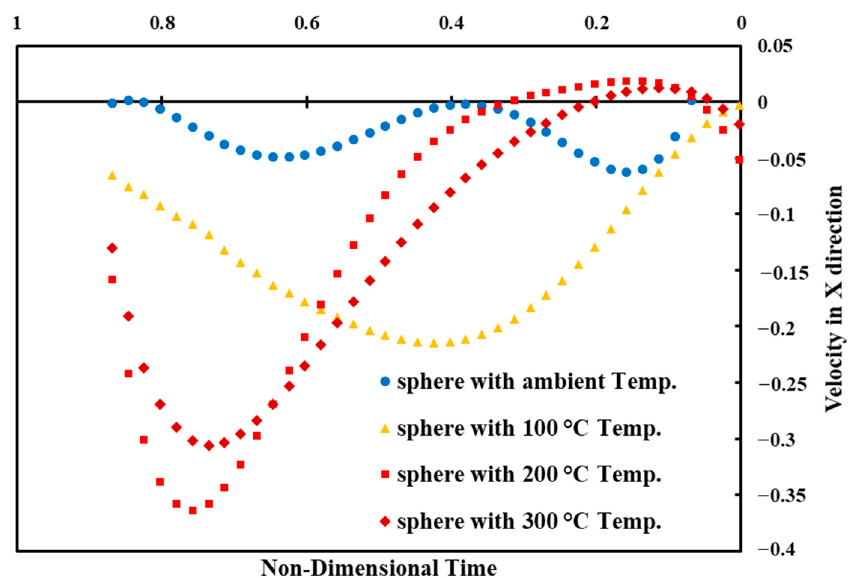
Figure 9. The horizontal velocity of the sphere versus dimensionless time for the sphere at different temperatures near the wall.